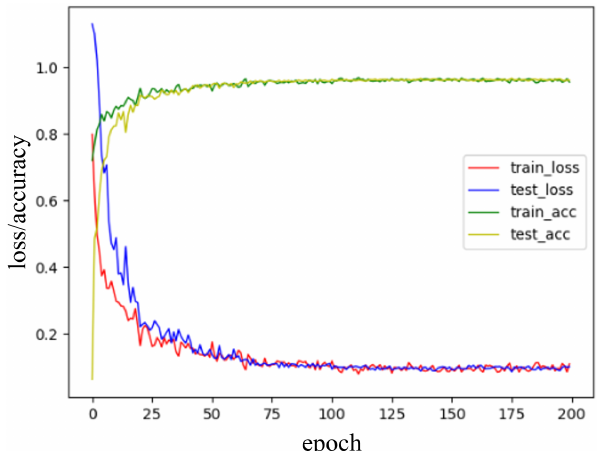
Figure 16. The trend of the training and test sets loss/accuracy during the model training.